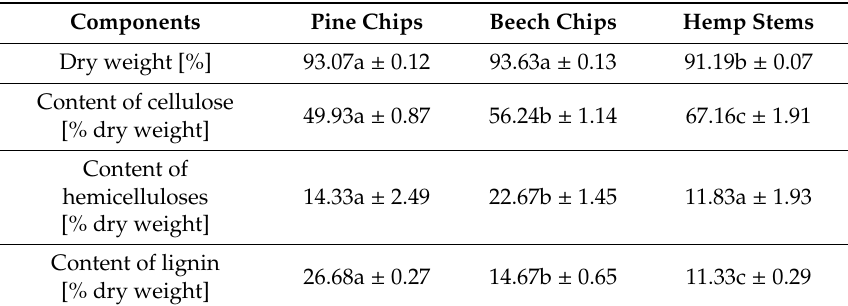
Table 1. Composition of plant biomass used in this study.